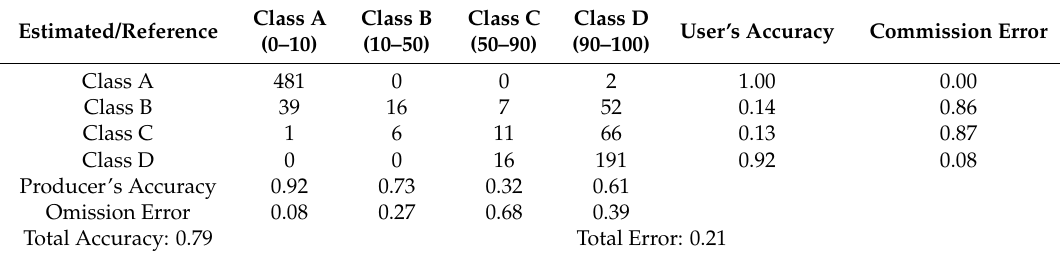
Table 7. Confusion matrices for Sodankylä ground camera.